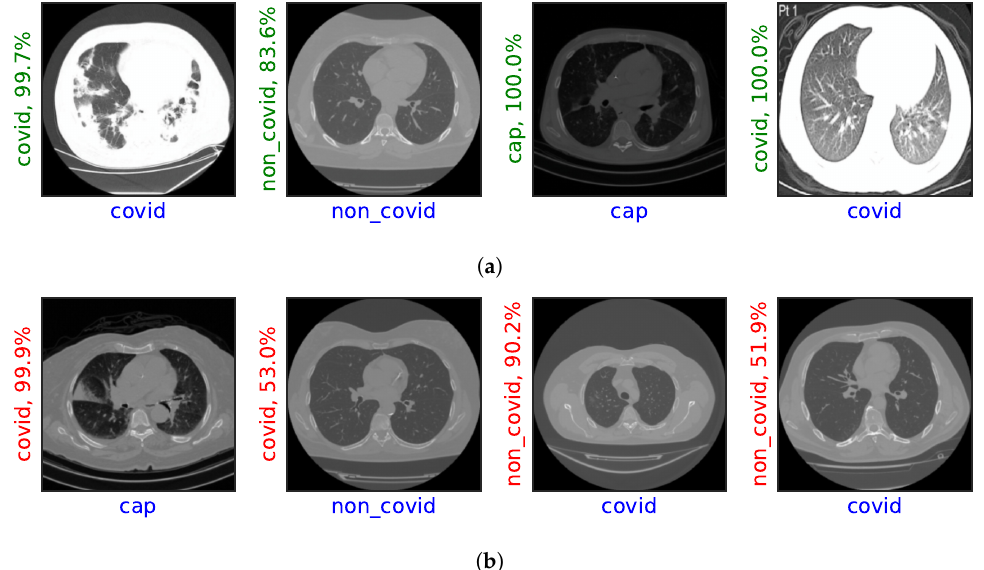
Figure 3. Illustration of results (horizontal label) with their prediction and probability score (vertical label). ( a ) Correct predictions. ( b )